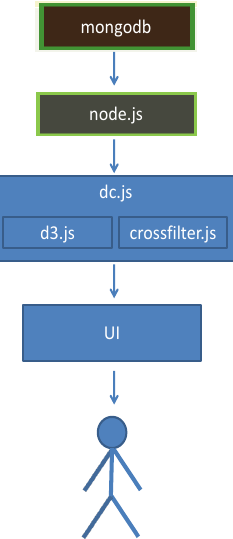
Figure 3: High level System Architecture: Image tile meta data are stored on a NoSQL database served by an event driven asyn- chronous RESTful interface. Coordinated views with 2D brush- ing in the client are based on a client side OLAP